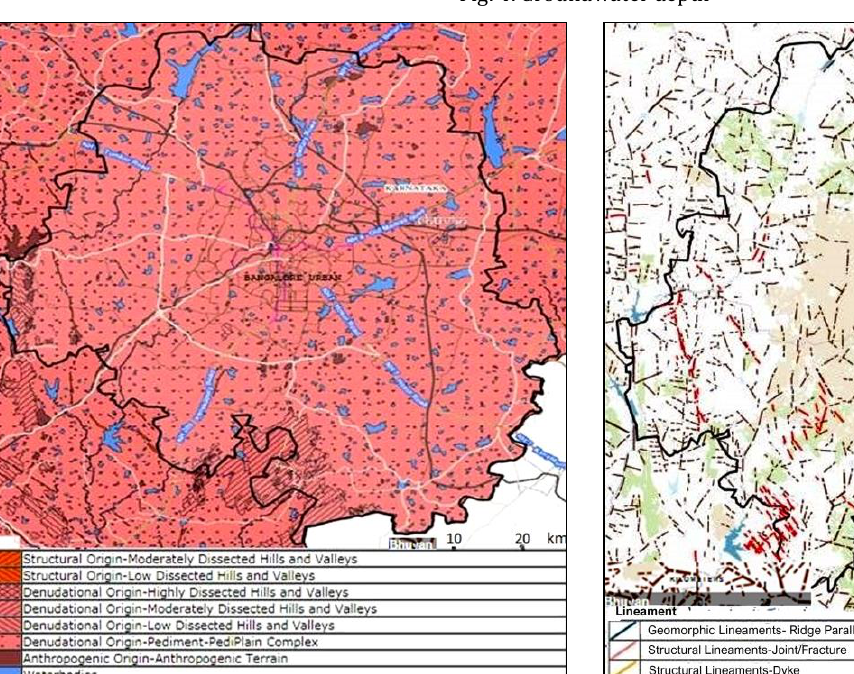
Fig. 4. Groundwater depth